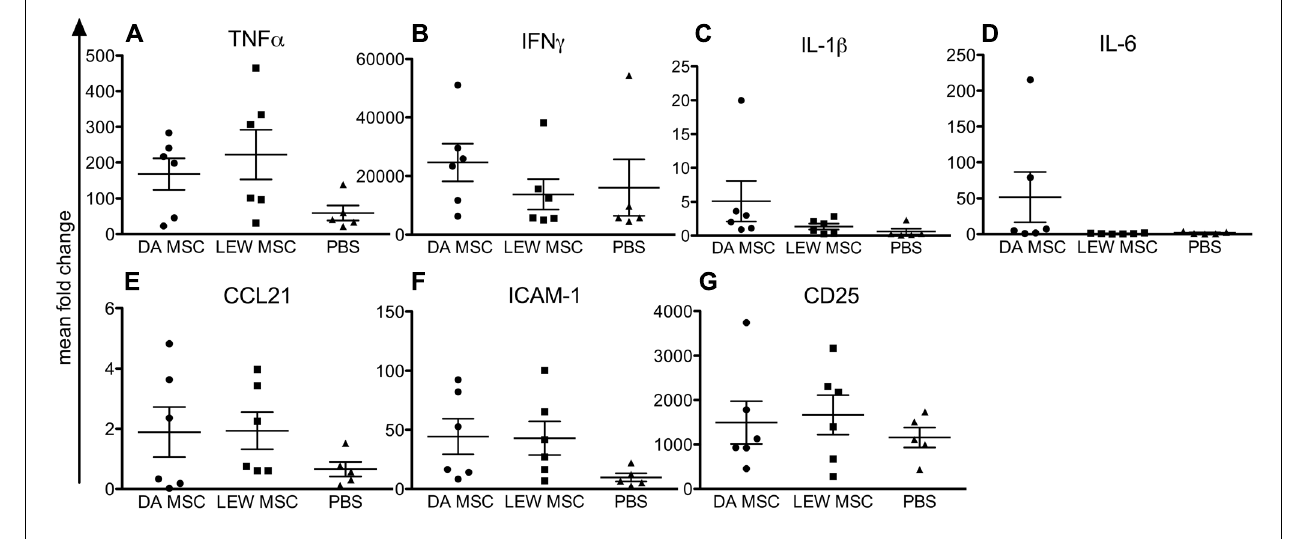
FIGURE 3 | Inflammation within the kidney grafts following MSC pre-treatment measured by intragraft gene expression analysis. Quantitative real-time PCR was performed on kidney grafts harvested 8–10 days after transplant. After expression of the target gene was normalized to the housekeeping gene β -actin, the mean fold increase of the target gene in